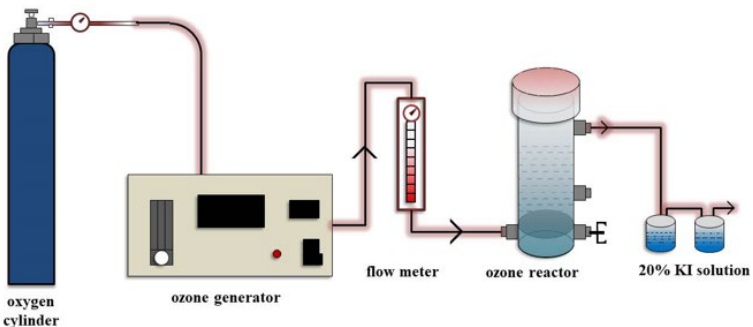
Figure 12. The schematic diagram of the catalytic ozone oxidation system.